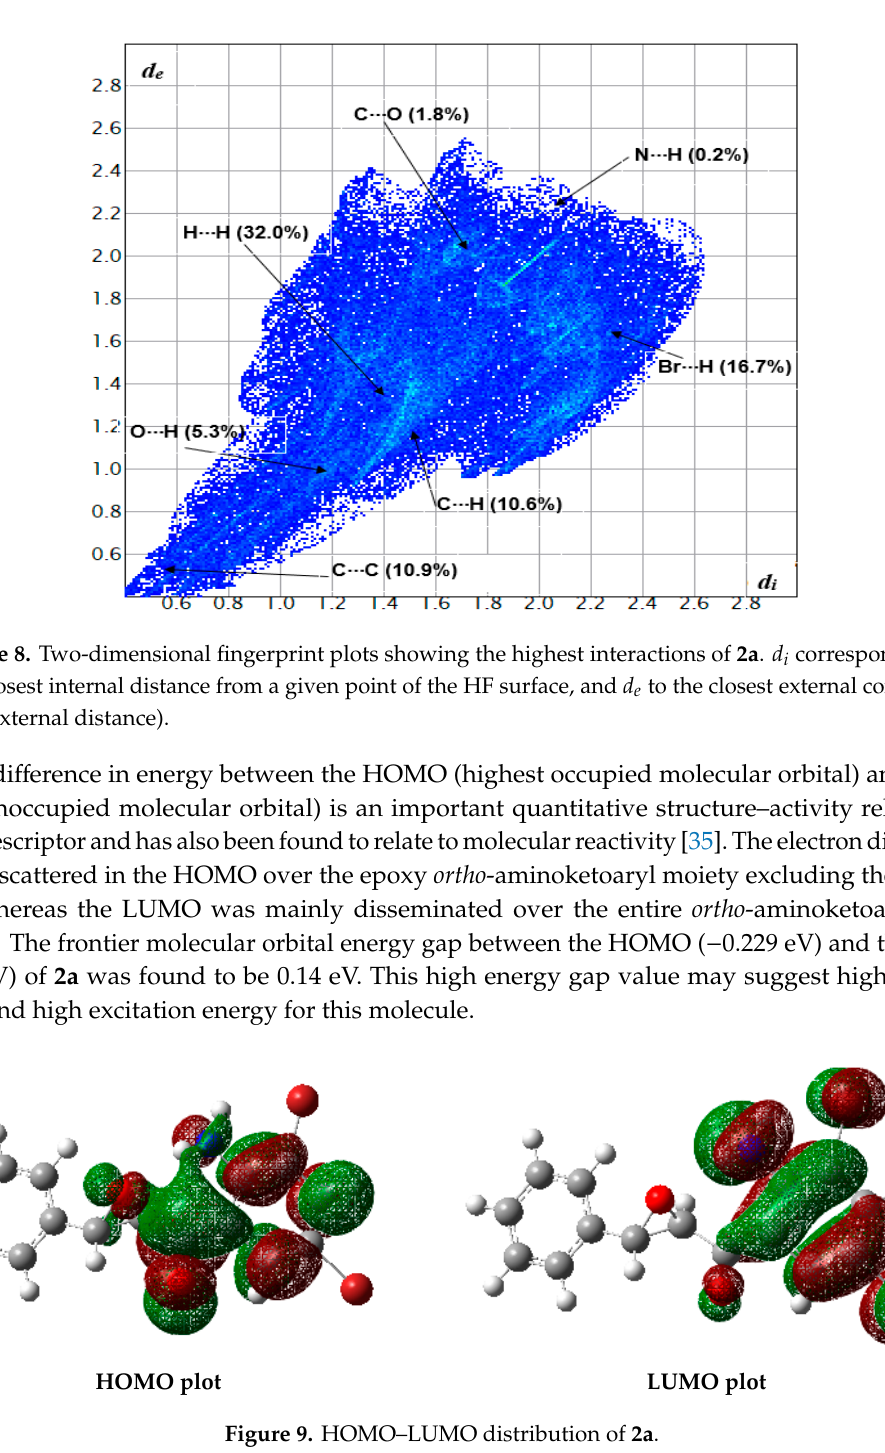
Figure 7. Hirshfeld surface of 2a mapped with the d norm function, and the regions of the most important intermolecular interactions are indicated by the dashed ovals and/or arrows.